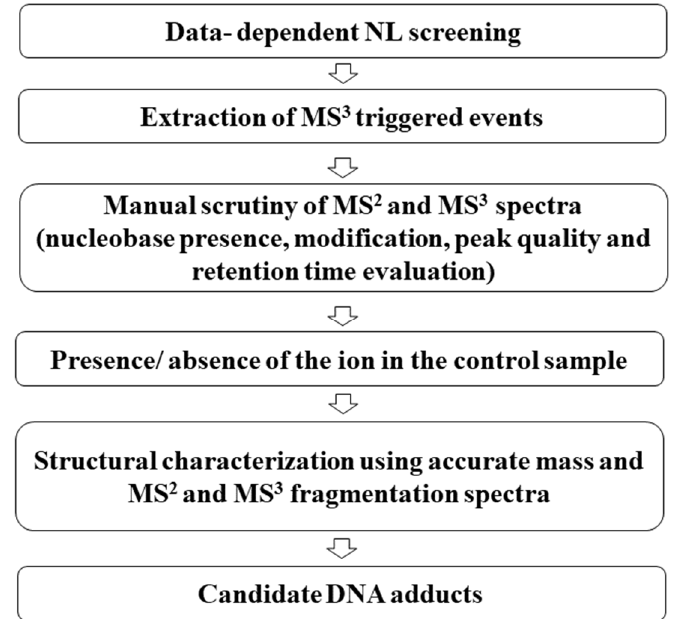
Figure 1. DNA-adductomics data-analysis workflow for DNA-adducts discovery.